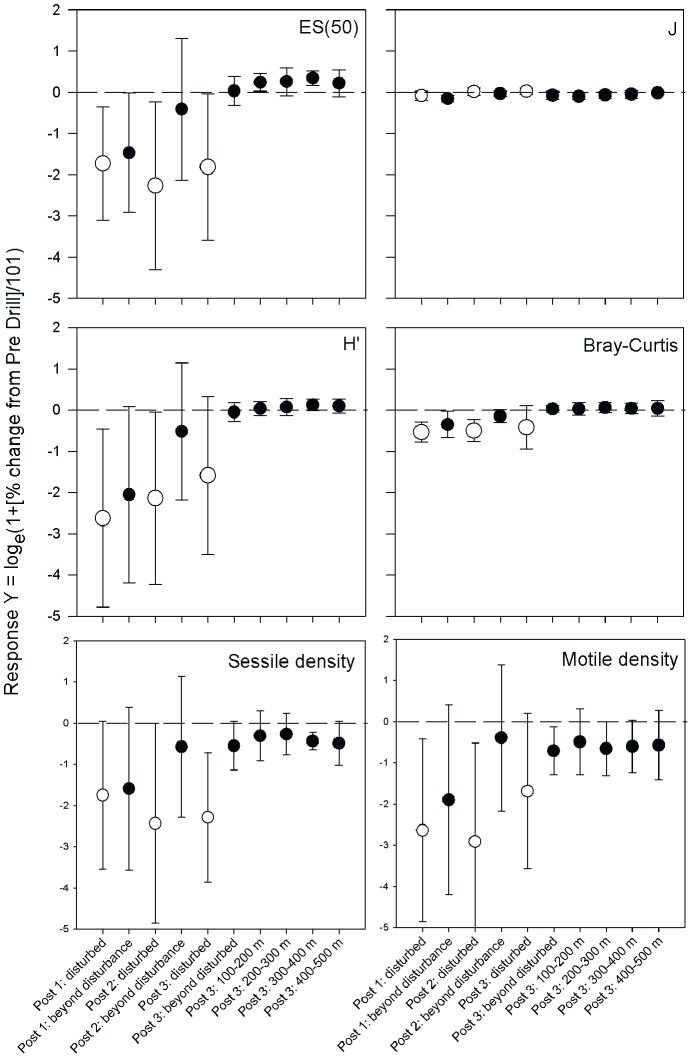
Response Y recovery index in comparison to pre-drill.Shown for Rarefied species richness (ES(50)), Species evenness (J), Shannon-Wiener Index (H′), Bray Curtis similarity, total sessile organism density and total motile organism density. Unfilled circles indicate disturbed zones and filled circles indicate distance from disturbance. Dashed lines indicate zero. Error bars = standard deviation.